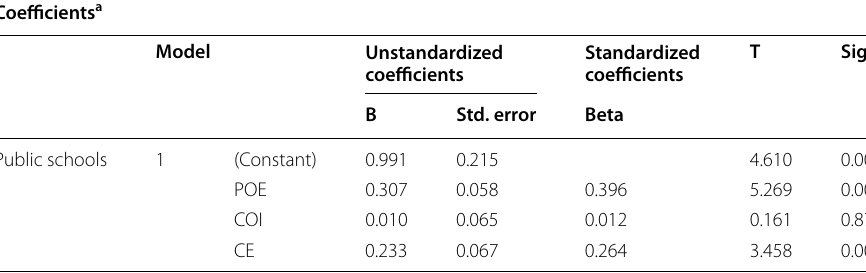
a Dependent variable: WTC b Predictors: (constant), CE, Grit Table 11 Coefficients of grit and CE for the public school students